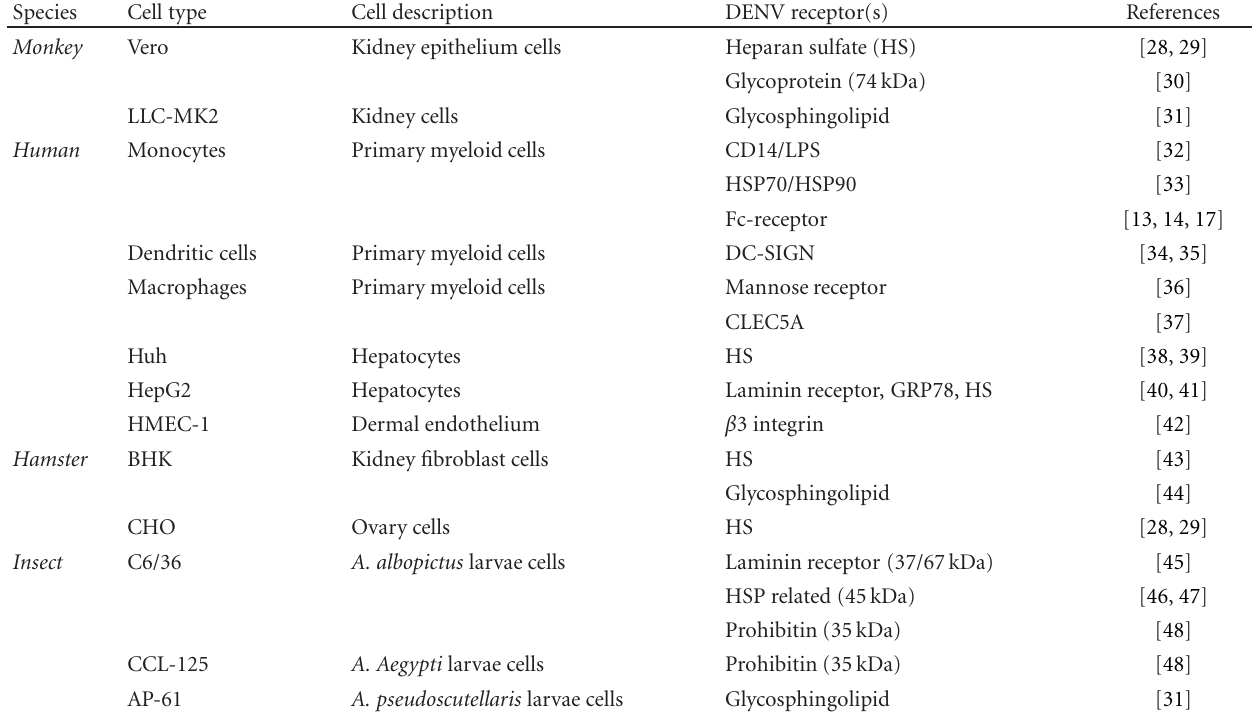
Table 1: Susceptible cell types for DENV infection and putative DENV